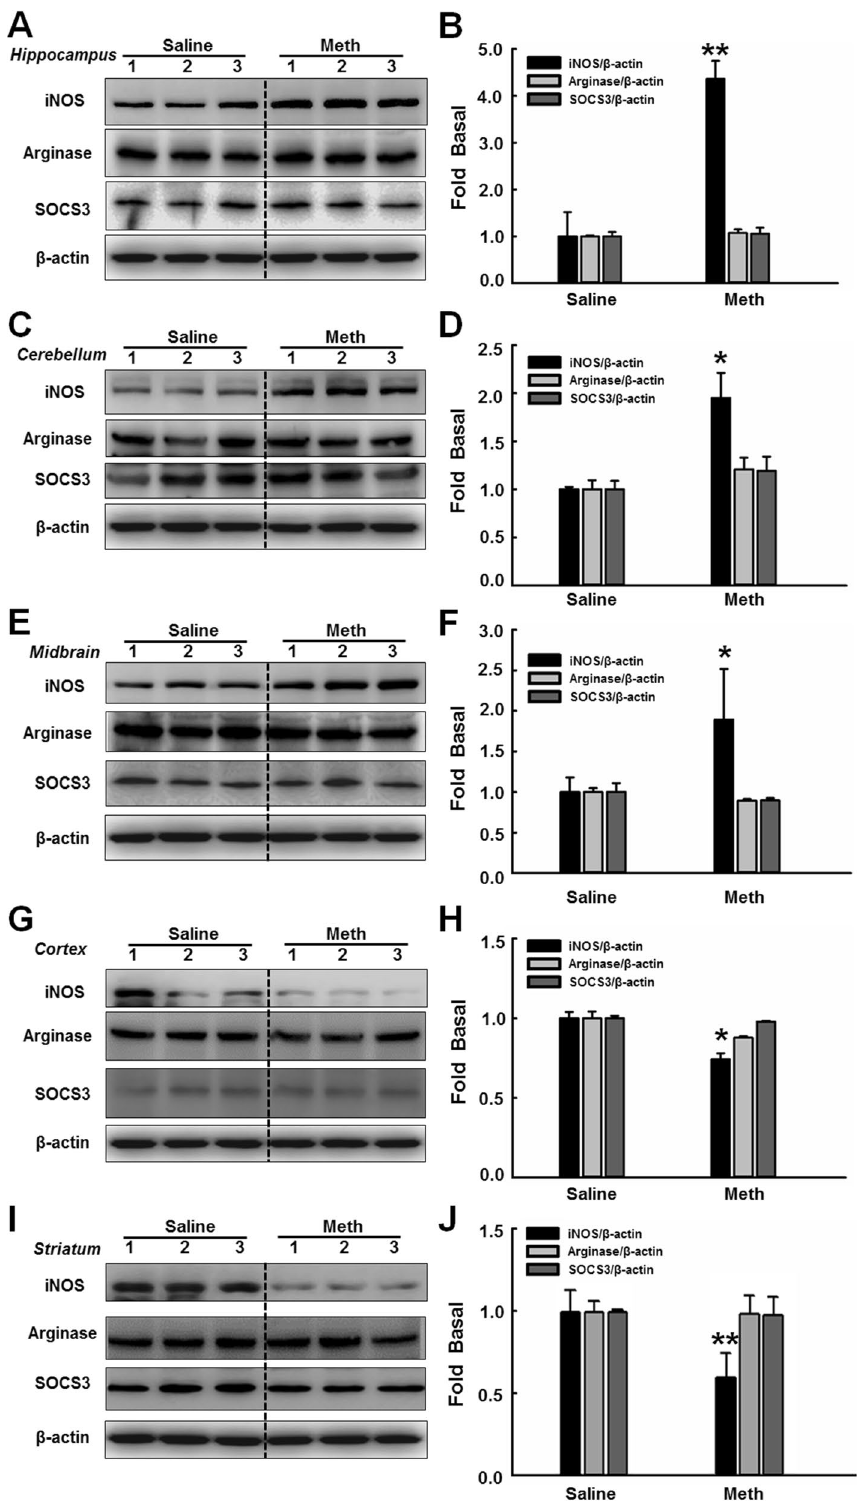
Figure 2. A correct version of the original Figure